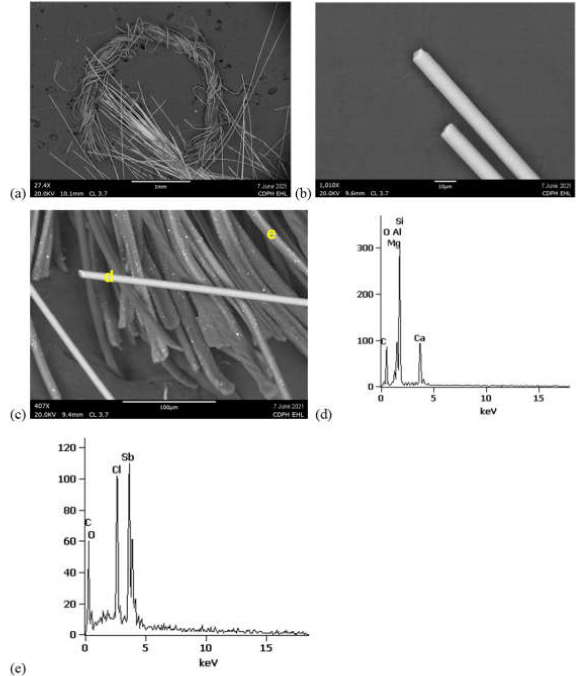
Figure 8. SEM-EDS from FG-4 inner sock. ( a ) Cut bundle of fiberglass and separate bundle of synthetic fibers. ( b ) Single fiberglass fibers with blunt ends and 8 um thickness. ( c ) Fiberglass fibers and synthetic fibers. ( d ) EDS acquired from fiberglass region marked in ( c ) showing Si, Al, and Ca. ( e ) EDS from bright spot in synthetic fiber marked in ( c ) exhibiting Cl and